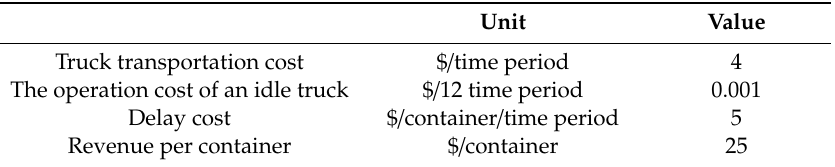
Table 4. Costs and fee